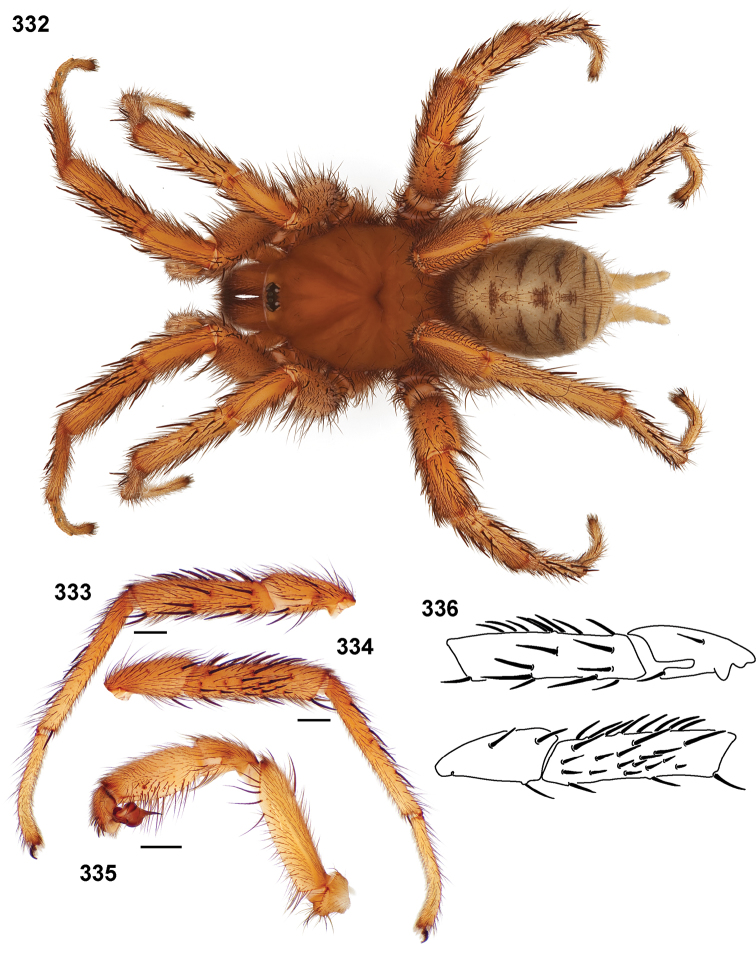
Aptostichus sierra sp. n. male holotype (AP400) from Fresno County; scale bars = 1.0mm. 332 habitus [806511] 333 retrolateral aspect, leg I [806515] 334 prolateral aspect, leg I [806517] 335 retrolateral aspect, pedipalp [806519] 336 line drawings of leg I tibia and patella spination patterns; retrolateral aspect; prolateral aspect.